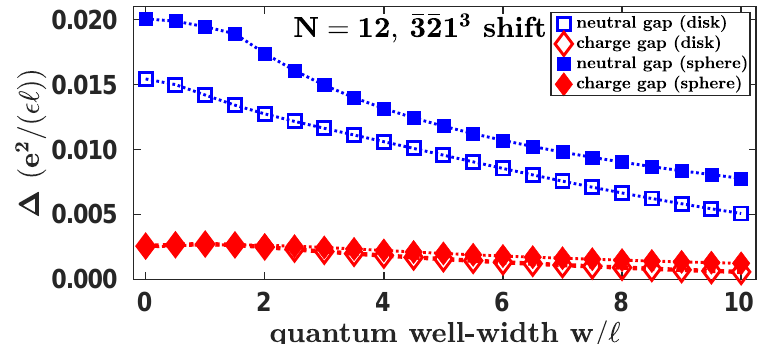
Figure 7: (color online) The second Landau level charge (red diamonds) and neutral (blue squares) gaps for N = 12 electrons at the shift corresponding to the ¯3¯21 3 state at ν = 6 / 13 evaluated in the spherical geometry using the spherical (filled symbols) and disk pseudopotentials (open symbols) for various well-widths w